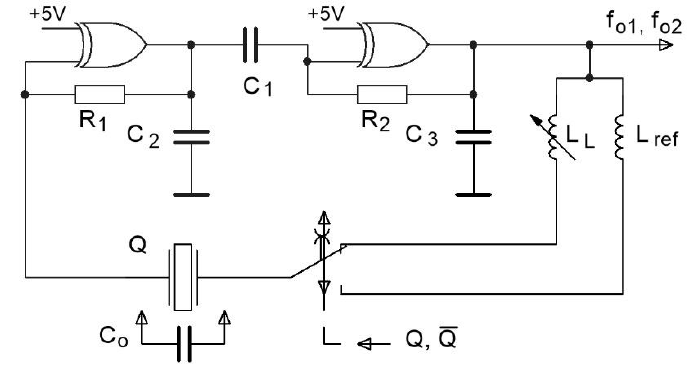
Figure 2. Switching of the oscillator inductances in the inductance-to-frequency converter.